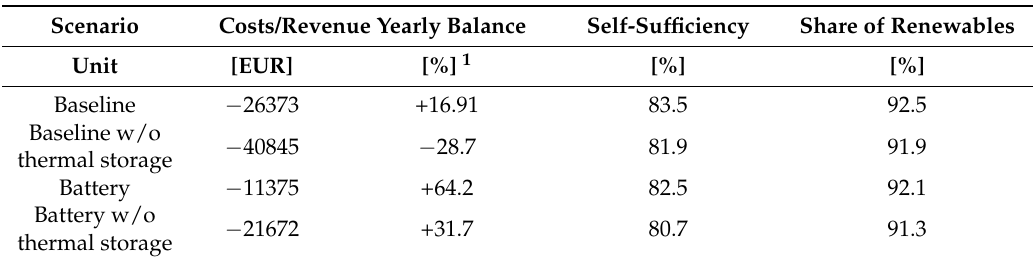
Table 4. Yearly profitability, self-sufficiency, and share of renewables for the baseline vs battery scenarios considering both spot and reserve